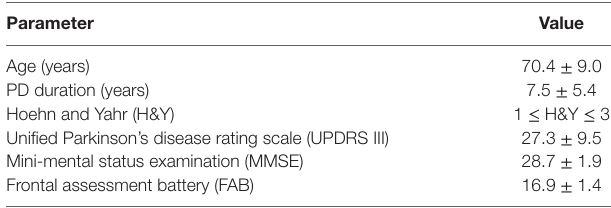
Table 1 | Main features of the 26 participants.